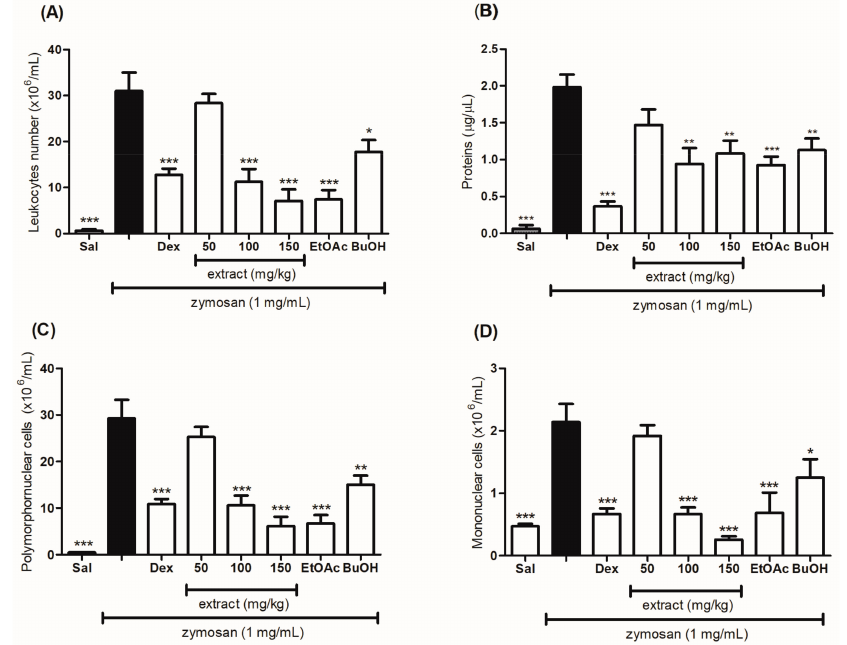
Figure 5. Evaluation of the anti-inflammatory effect of the hydroethanolic extract and the ethyl acetate (EtOAc) and n -butanol (BuOH) fractions of T. catharinensis leaves on leukocytes migration and